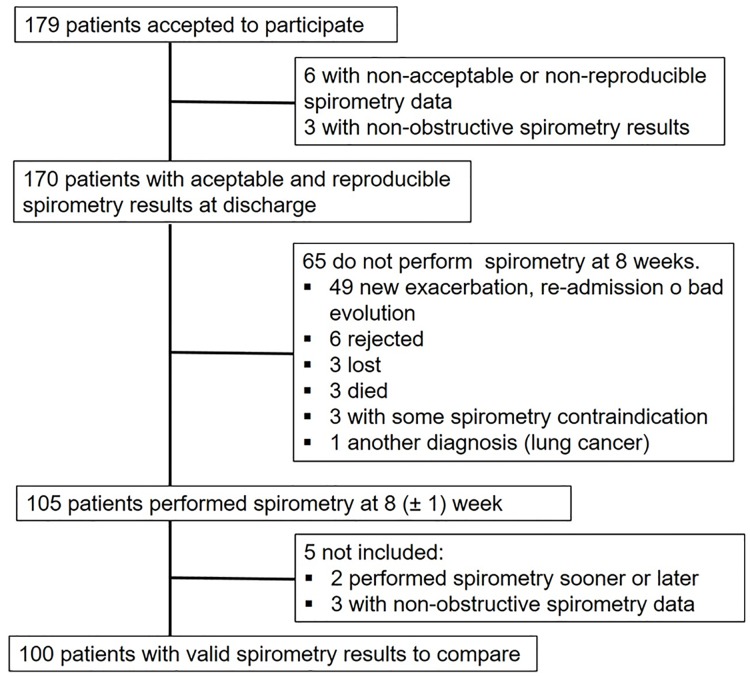
Patient flowchart.